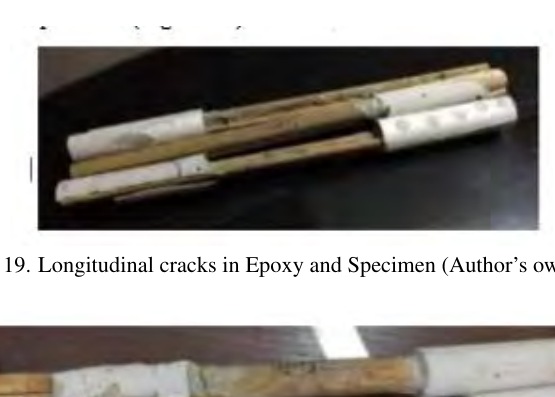
Figure 18. The tension procedures in the testing machine (Author’s own, n.d.)